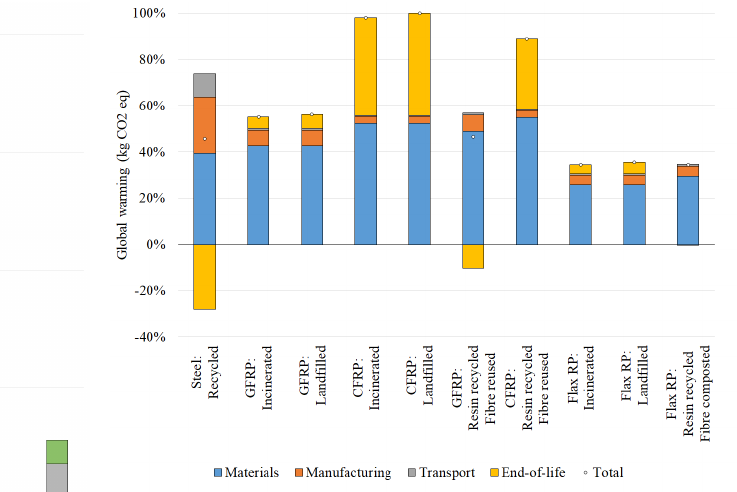
Fig. 5. Life cycle greenhouse gas emissions for ten turbine blade material and treatment